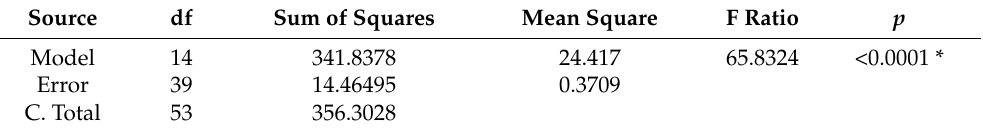
Table 4. Lack of Fit for a nonlinear model of the layer thickness ( t h ). Source df Sum of Squares Mean Square F Ratio p Lack Of Fit 36 13.69565 0.380435 1.4836 0.4264 Pure Error 3 0.7693 0.256433 Total Error 39